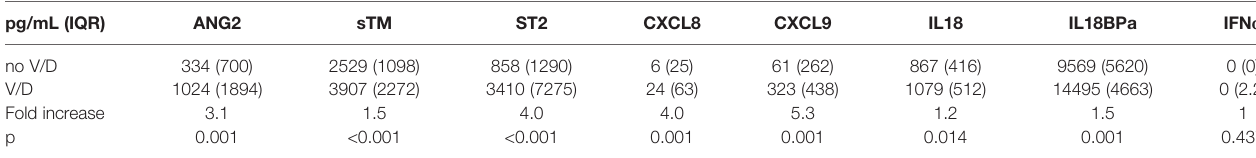
TABLE 3 | Endothelial and immune markers at hospital admission in the training cohort (total, n=83; no V/D, n=62; V/D, n=21). pg/mL (IQR) IFN a no